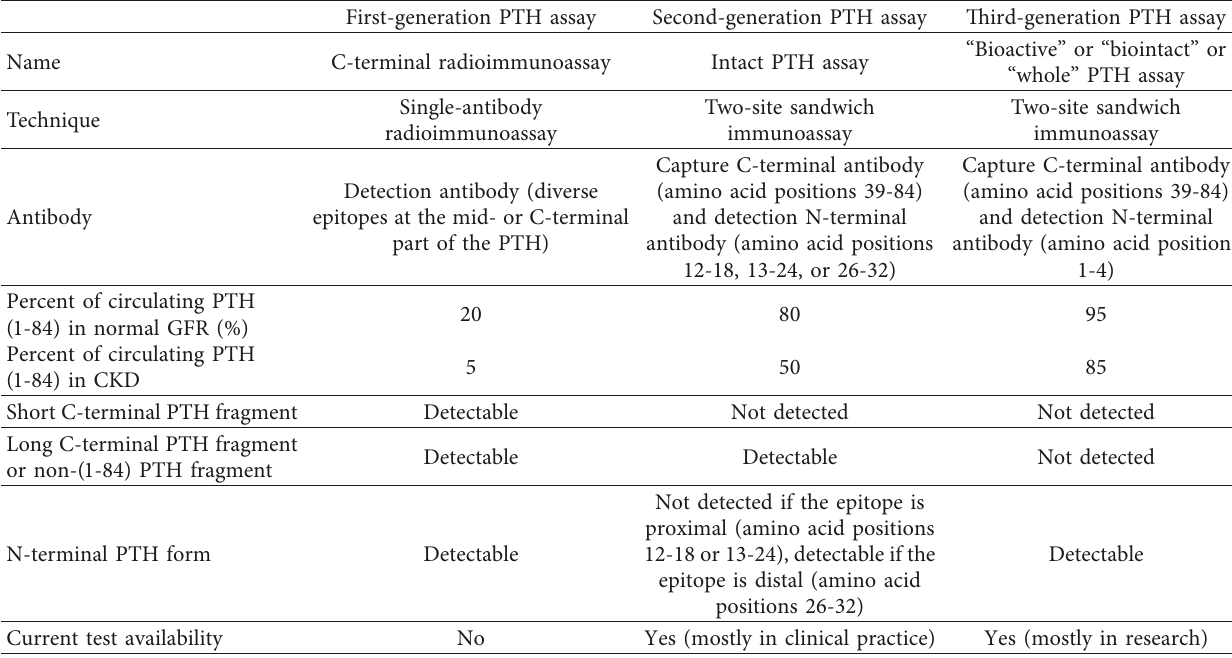
Table 1: Comparison among the three generations of PTH